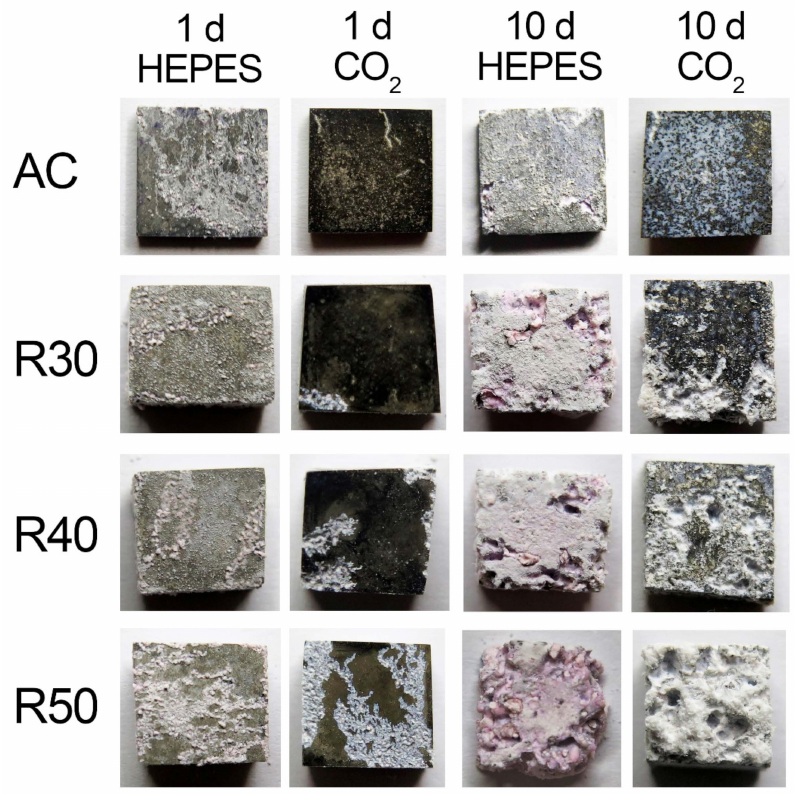
Figure 2. Photographs of the as-corroded surfaces of AC and RX as a function of immersion time and buffer system in